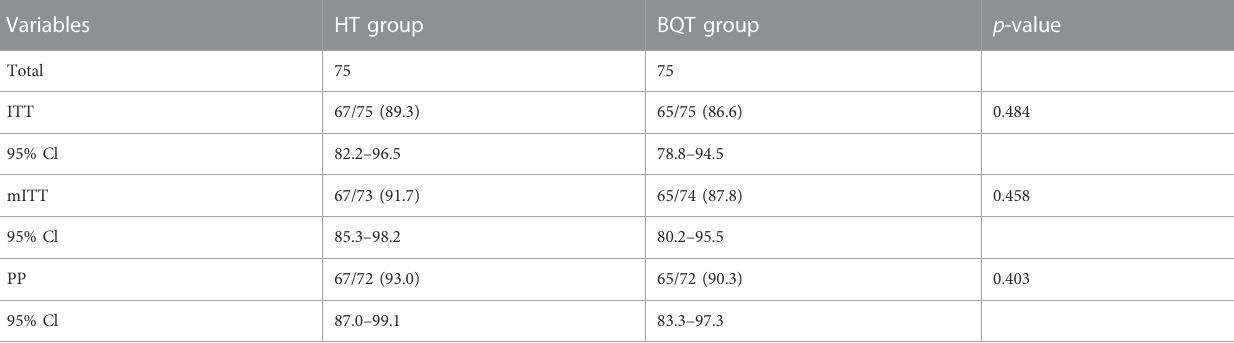
TABLE 2 Eradication rates in each regimen. Variables